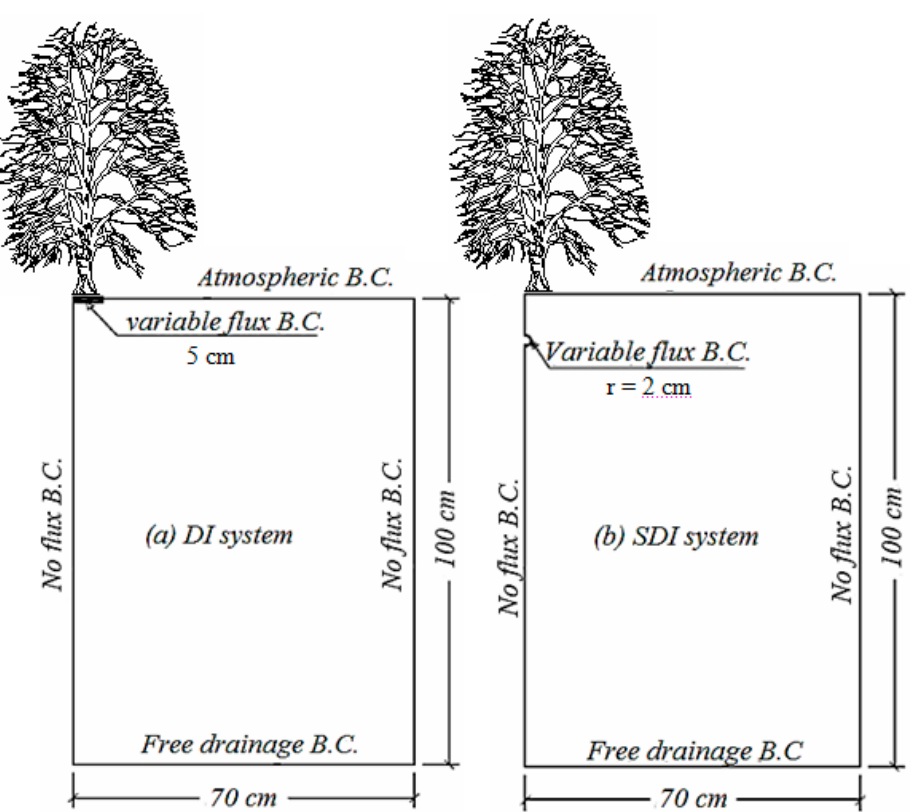
Figure 1. Simulation domain for the investigated drip irrigation (DI) and subsurface drip irrigation (SDI) systems. Soil Parameters.